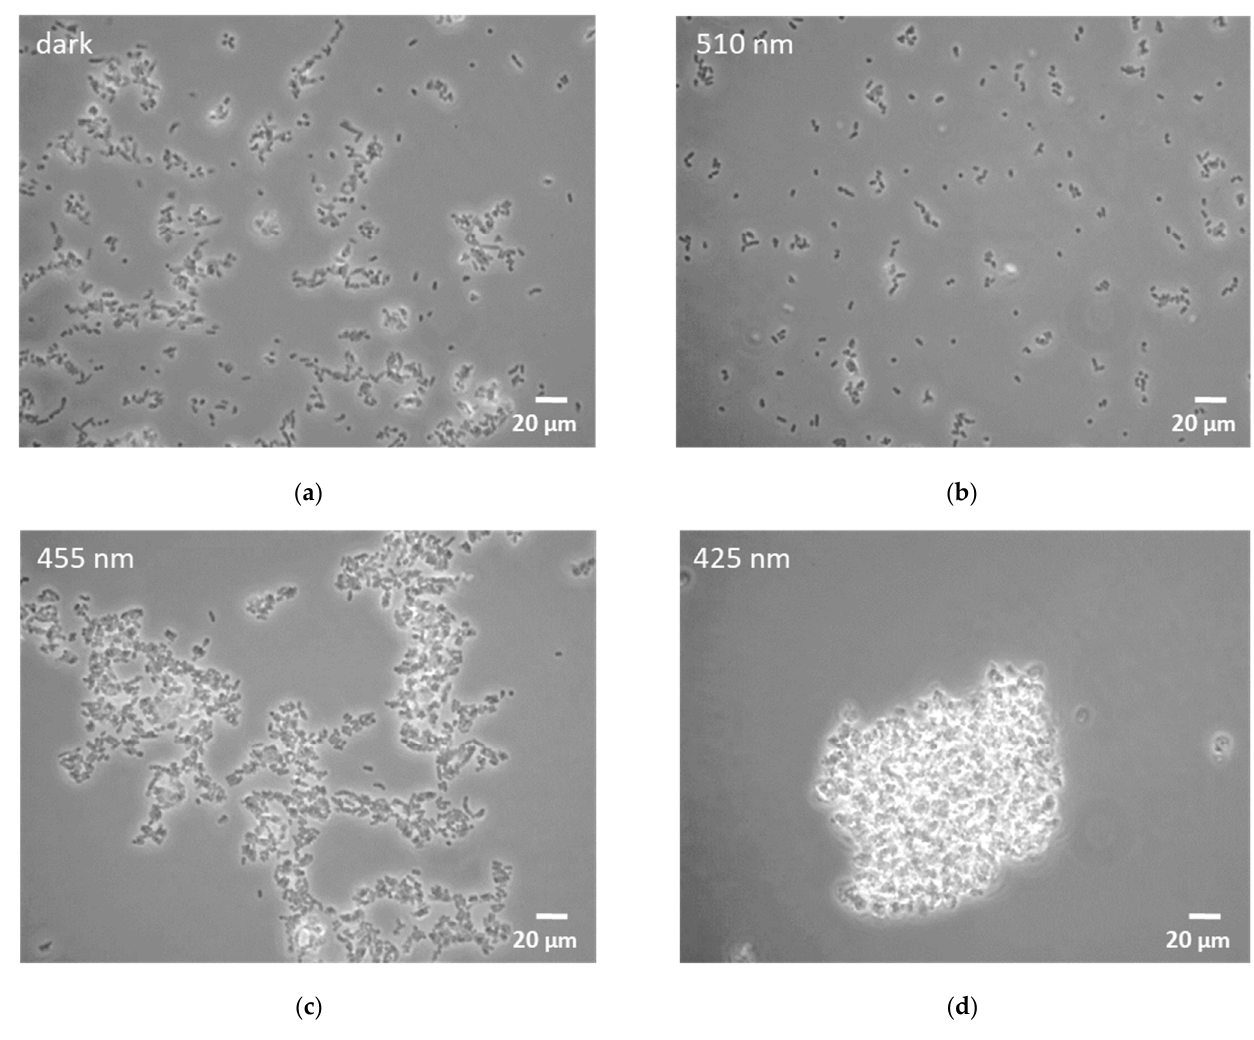
Figure 2. Microscopy images of R. erythropolis exposed to selected light conditions for 46 h. ( a ) Non- illuminated control; ( b ) green light (510 nm); ( c ) blue light (455 nm); ( d ) blue light (425 nm). Scale bar indicates a length of 20 μ m.